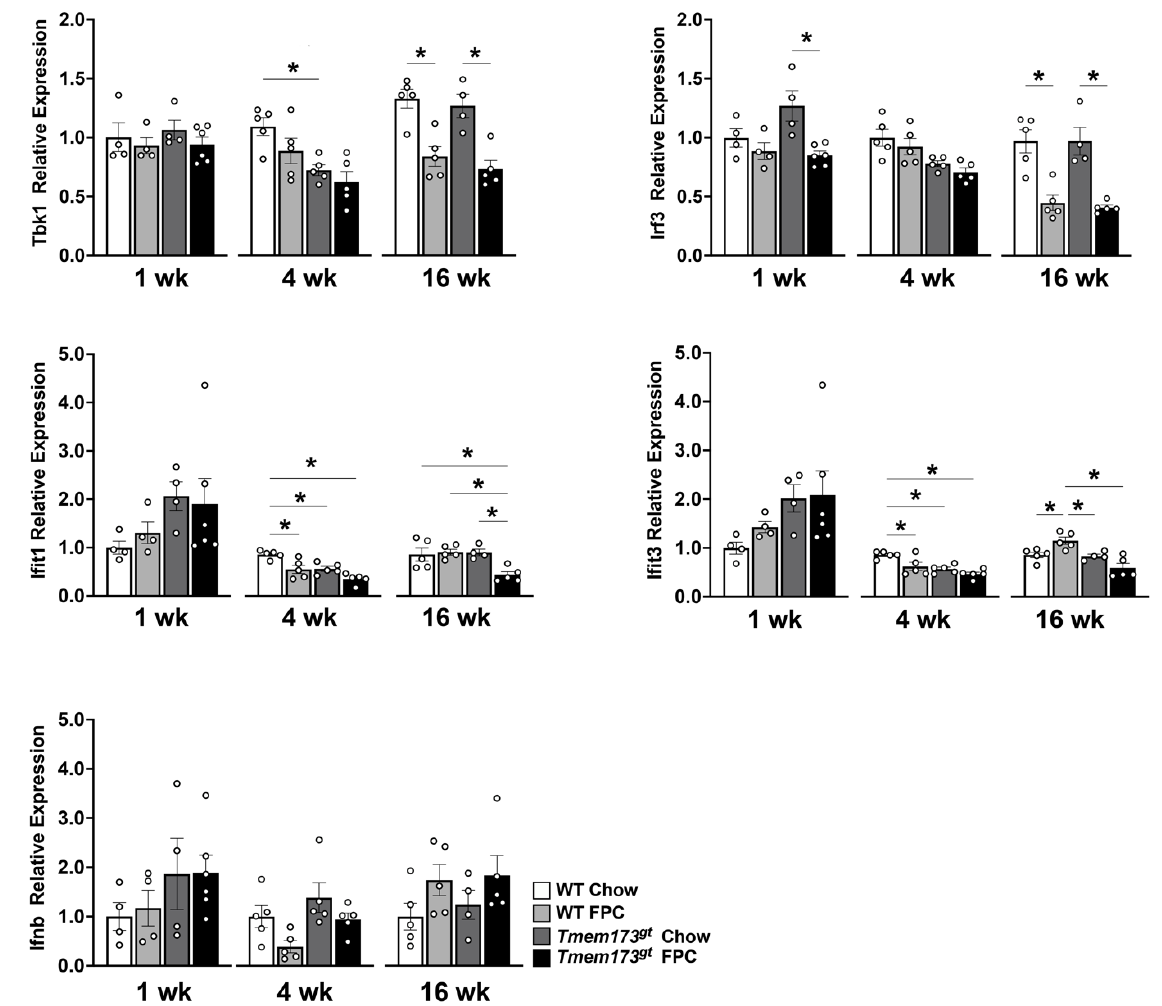
Figure 6. Gene expression levels of STING downstream pathways. Relative expression of Tbk1 , Irf3 , Ifit1 , Ifit3 , and Ifnb at 1, 4, and 16 wk following chow or FPC feeding in WT and Tmem173 gt mice. Graphs represents means ± SEM. * p < 0.05 to respective group.